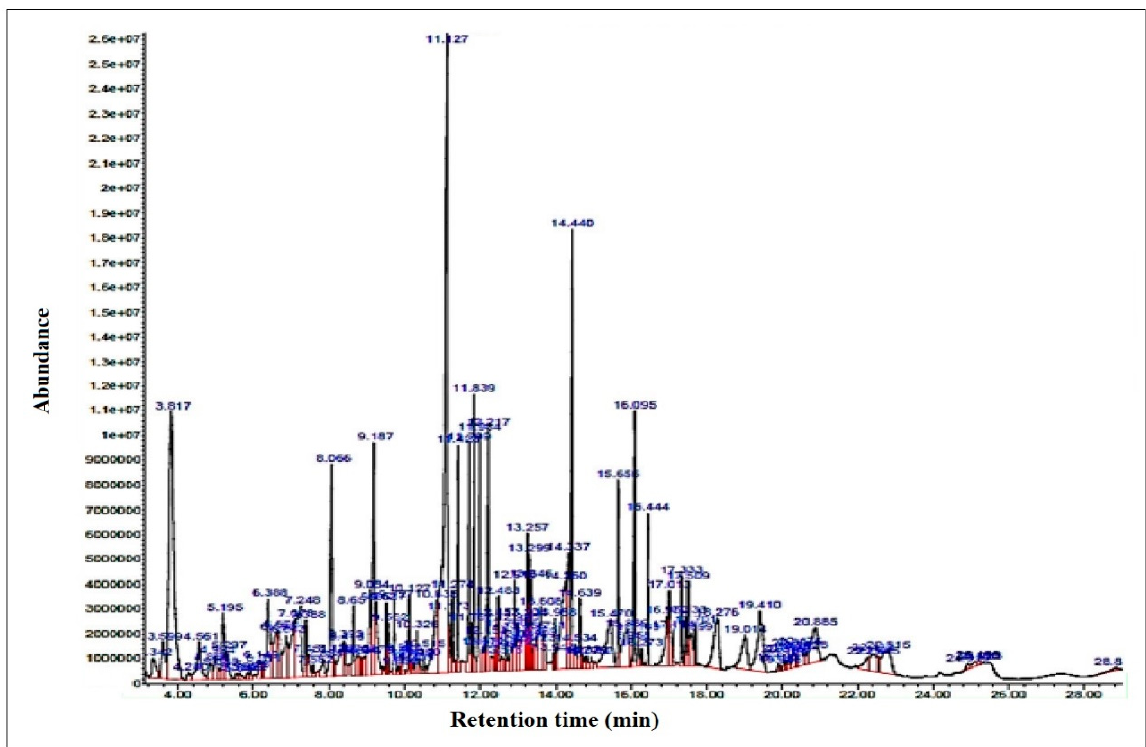
Figure 6. GCMS of oil collected from the pyrolytic decomposition of lignin in the absence of cata ‐ lyst. Table 2. Composition of bio ‐ oil collected from lignin pyrolysis in the absence of catalyst